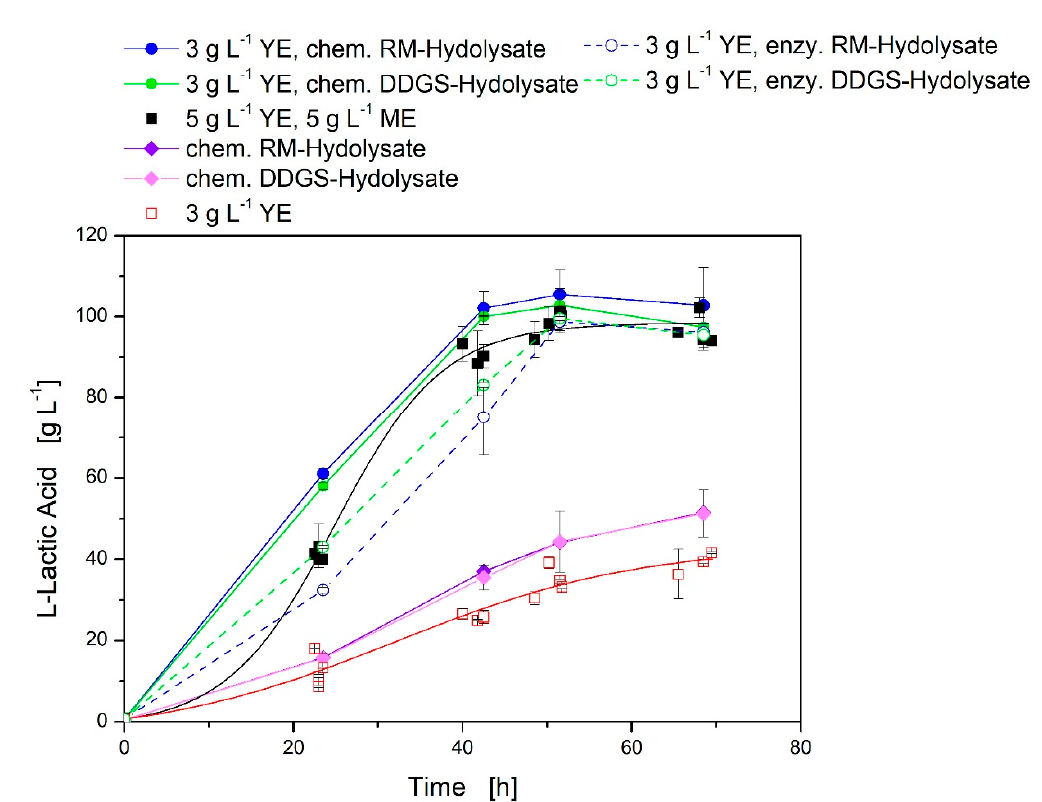
Figure 3. Use of di ff erent agricultural residue hydrolysates instead of complex medium components in modified MRS medium with 5 g · L − 1 yeast extract (YE) and 5 g · L − 1 meat extract (ME) and limited MRS Figure 3. Use of different agricultural residue hydrolysates instead of complex medium components medium with 3 g · L − 1 yeast extract for l -lactate production with L. casei in 24-well plates at 37 ◦ C and in modified MRS medium with 5 g·L − 1 yeast extract (YE) and 5 g·L − 1 meat extract (ME) and limited 400 rpm: the total nitrogen amount was kept constant comparable to 5 g · L − 1 yeast extract and 5 g · L − 1 MRS medium with 3 g·L − 1 yeast extract for L -lactate production with L. casei in 24-well plates at 37 °C meat extract. Black, closed squares modified MRS medium with 5 g · L − 1 yeast extract and 5 g · L − 1 meat and 400 rpm: the total nitrogen amount was kept constant comparable to 5 g·L − 1 yeast extract and 5 extract; red, opened squares limited MRS medium with 3 g · L − 1 yeast g·L − 1 meat extract. Black, closed squares modified MRS medium with 5 g·L − 1 yeast extract and 5 g·L − 1 meat extract; red, opened squares limited MRS medium with 3 g·L − 1 yeast extract.